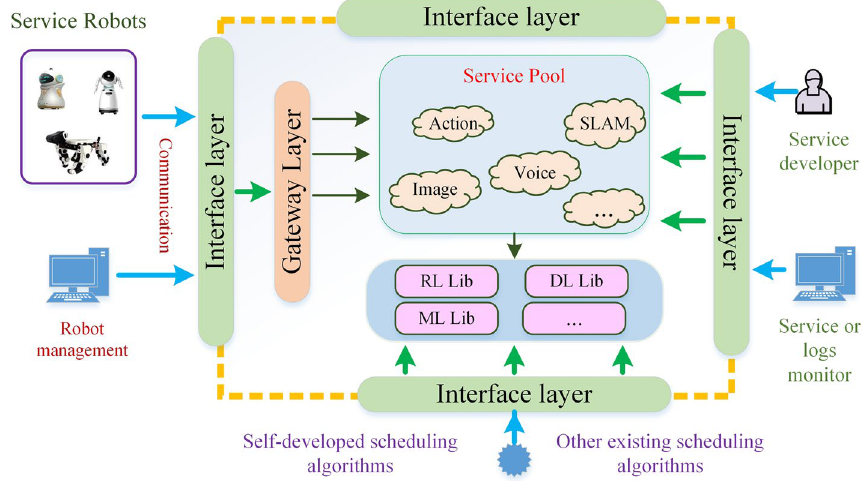
Fig. 1 The main architecture of robot service cloud